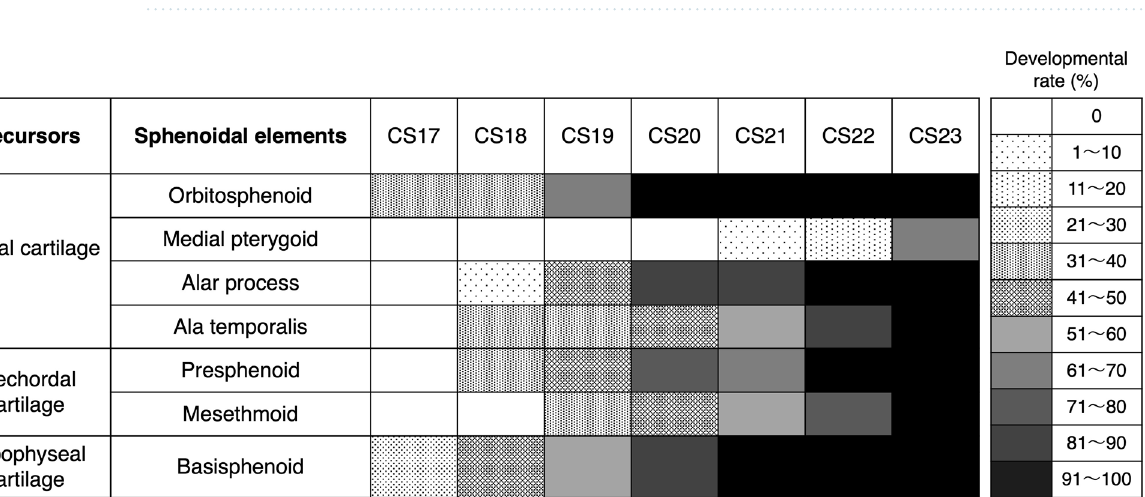
Figure 1. An example of cartilaginous elements in CS20 are observed using HS ( a ) and PCX-CT ( b ). These specimens include both cartilaginous matrix and condensation. Elements with chondrified matrix surrounded by perichondrium (e.g., basisphenoid) in HS are observed as low-density areas surrounded by a high-density outline in PCX-CT. Arrow heads show the perichondrium. Condensation of chondrocytes (e.g., mesethmoid) in HS is observed as high-density area in PCX-CT. CS, Carnegie stage; HS, histological section; PCX-CT, phase- contrast CT; AT, ala temporalis; AP, alar process; B, basisphenoid; ME, mesethmoid; R, root of orbitosphenoid; TN, trigeminal nerve.